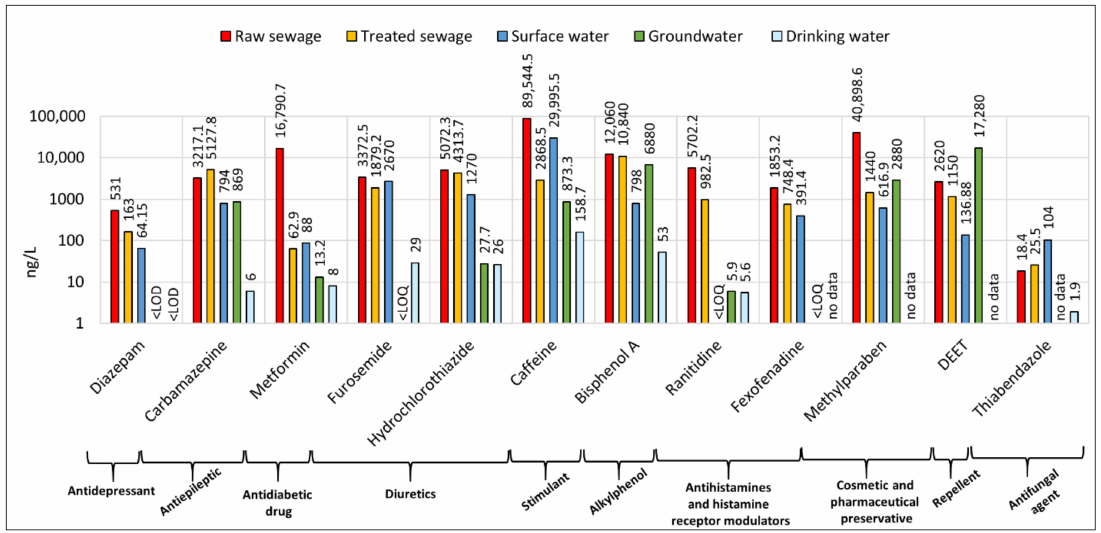
Figure 8. Variations in maximum concentrations of selected PPCPs in different water sample